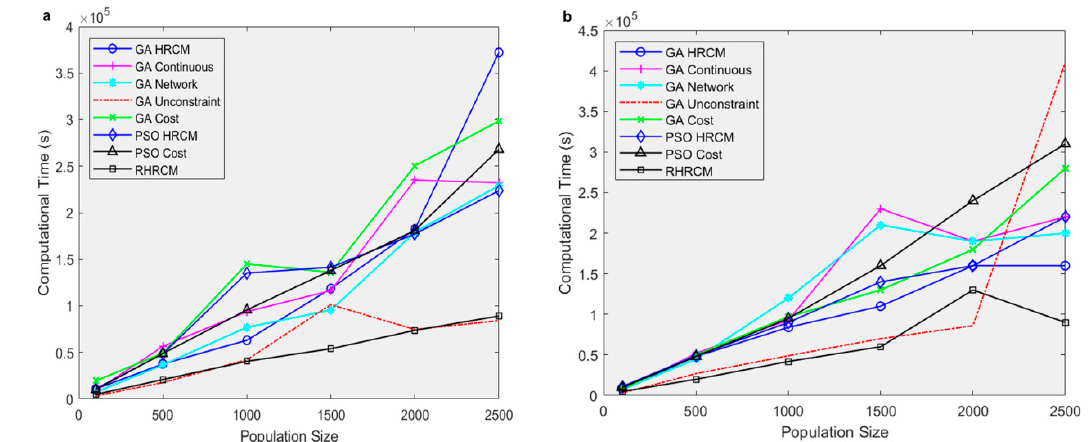
Figure 5. The time competition for seven methods: ( a ) scenario 1; ( b ) scenario 2.